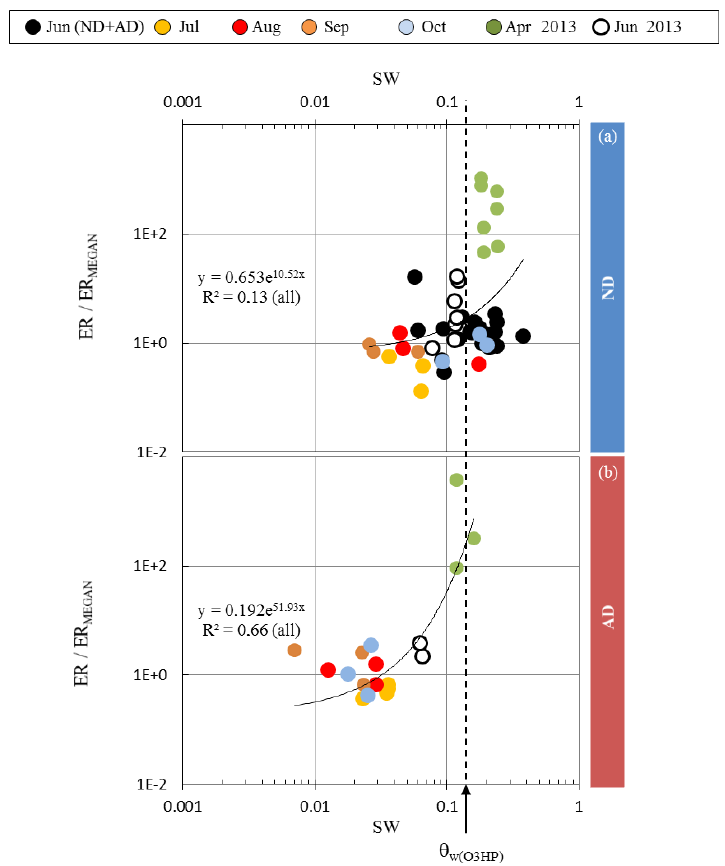
Figure 4. Ratio between observed (ER) and calculated (ER MEGAN ) isoprene emission rates vs. the soil water content SW measured at the O 3 HP, under (a) ND ( n = 267) and (b) AD ( n = 138). Given that the rain exclusion device was only implemented just before our study began in June 2012, the ND and AD measurements were considered together for June 2012. The dotted line is for SW = θw measured at O 3 HP (0.15m 3 m − 3 )